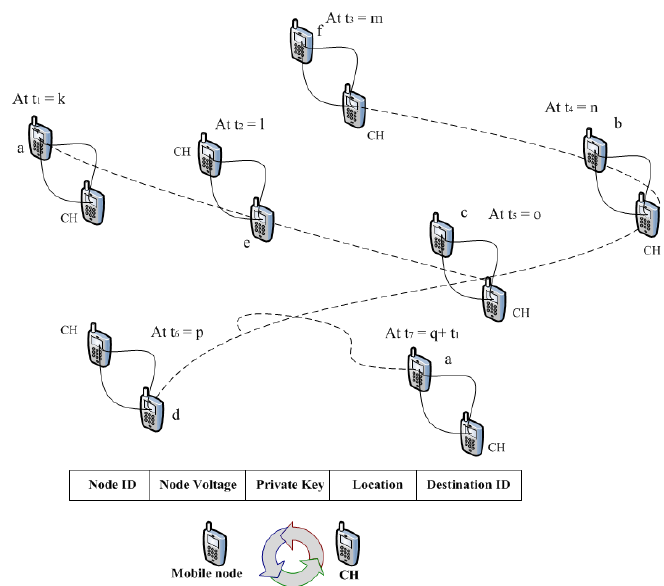
Figure 3. Mobile node encounter to other node at various time